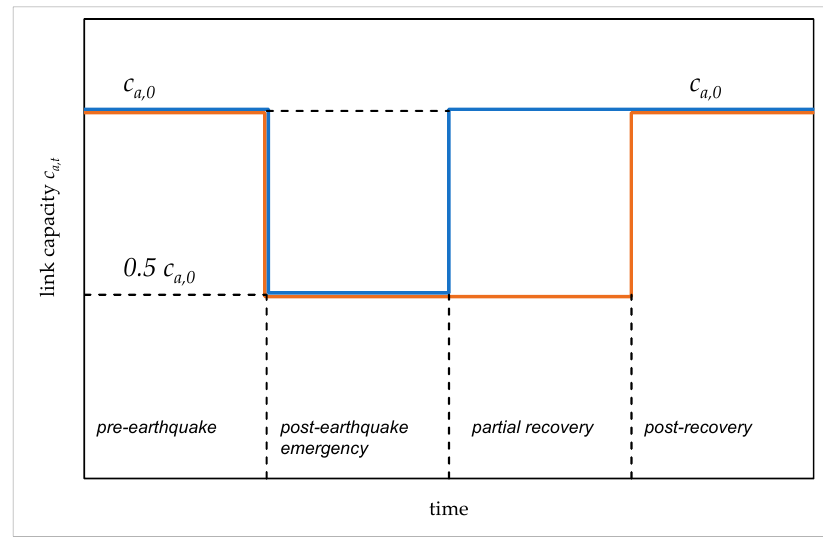
Figure 4. link capacity vs. time relationship. Figure 4. Link capacity vs. time